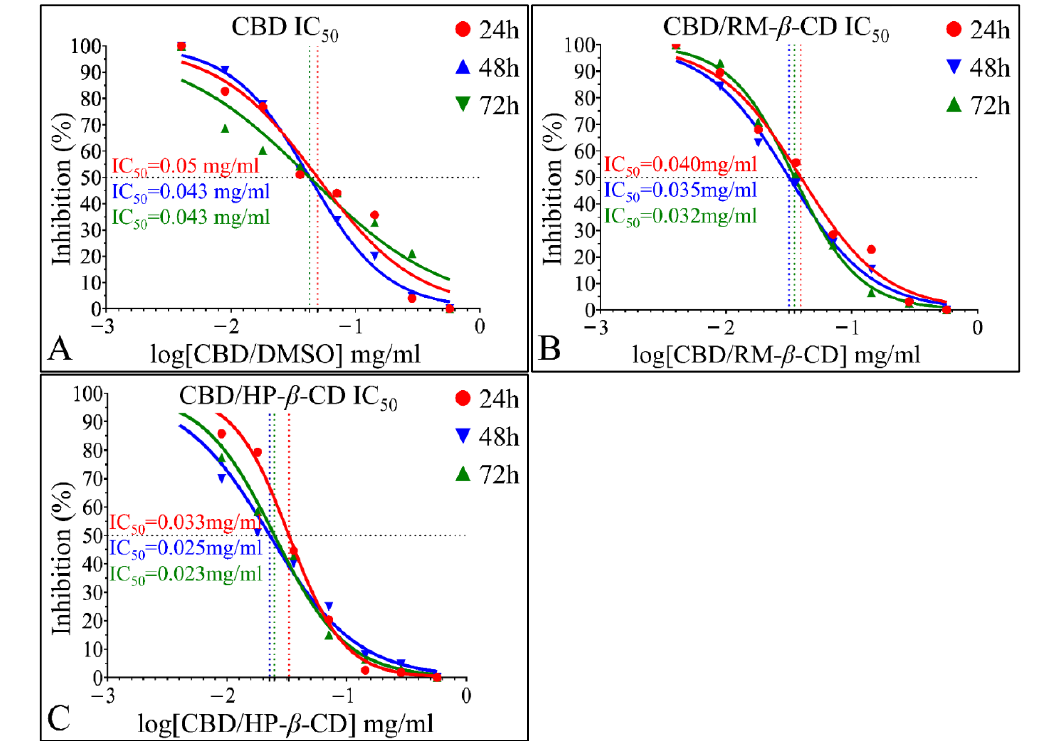
Figure 10. Calculation of IC 50 of CBD and its inclusion complexes on A172 cells. ( A ) IC 50 values were calculated to be 0.049 ( R 2 = 0.96) at 24 h, 0.043 mg/mL at 48 h, and 0.043 at 72 h for the sole CBD in DMSO; ( B ) the IC 50 for the CBD/RM- β -CD inclusion complex was 0.040 mg/mL at 24 h, 0.035 mg/mL at 48 h, and 0.032 mg/mL at 72 h; ( C ) the IC 50 for the CBD/HP- β -CD inclusion complex was 0.033 mg/mL at 24 h, 0.025 mg/mL at 48 h, and 0.023 mg/mL at 72 h.